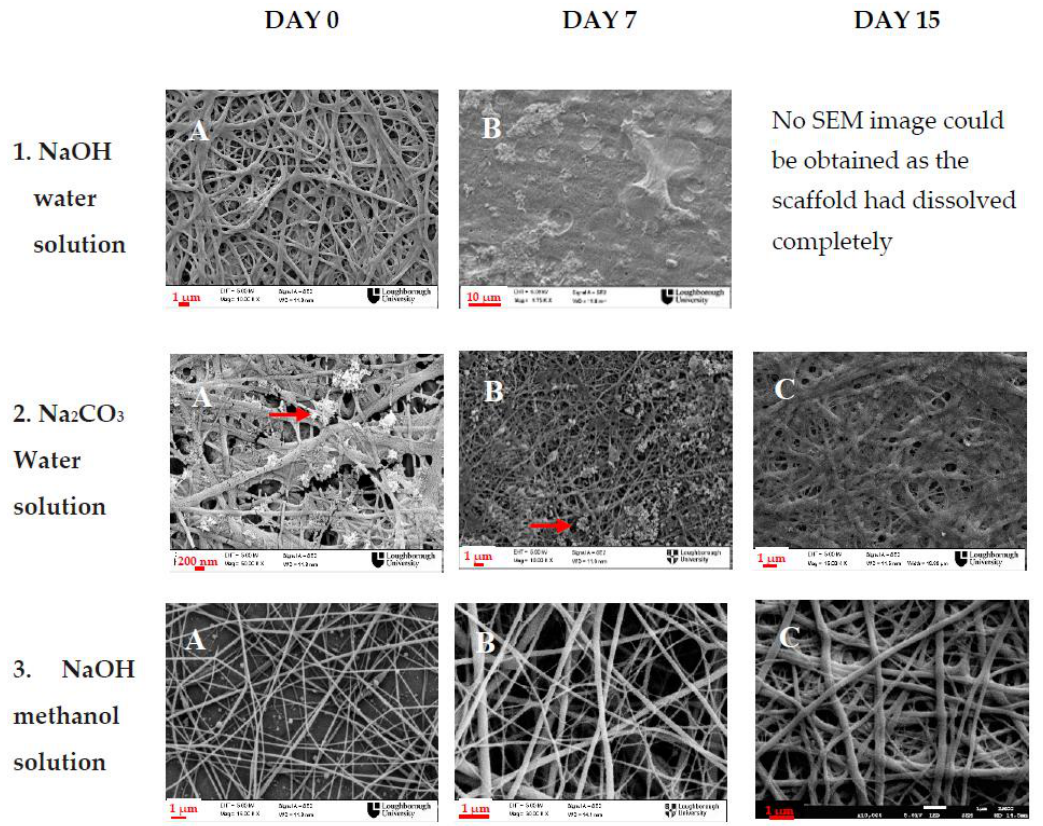
Figure 2. Electrospun chitosan containing membranes after neutralization and immersion in Phosphate Buffered Saline (PBS) after 7 and 15 days.